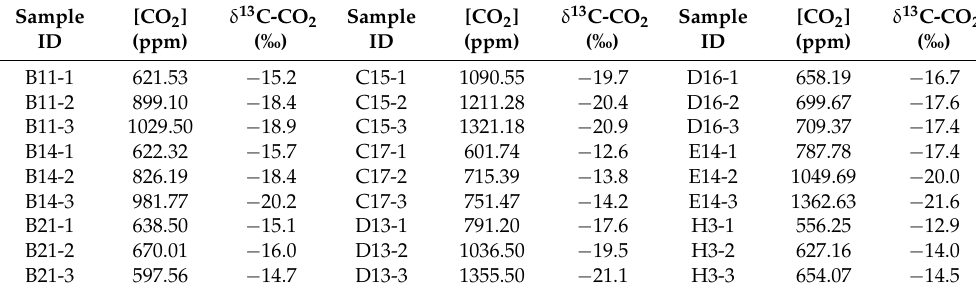
Table 1. Isotope ratio results for Hudson site.